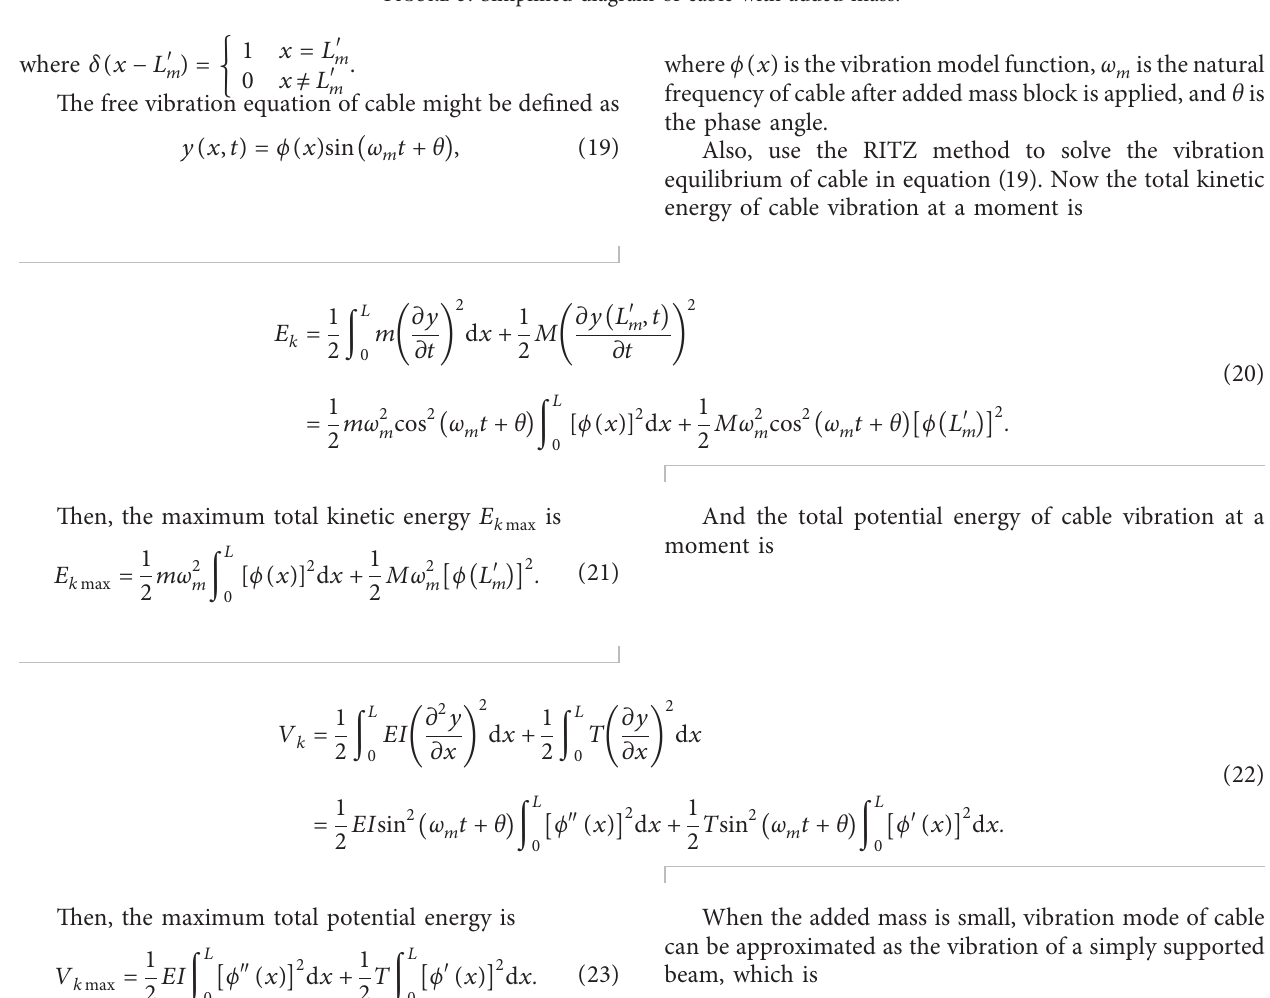
Figure 5: Simplified diagram of cable with added